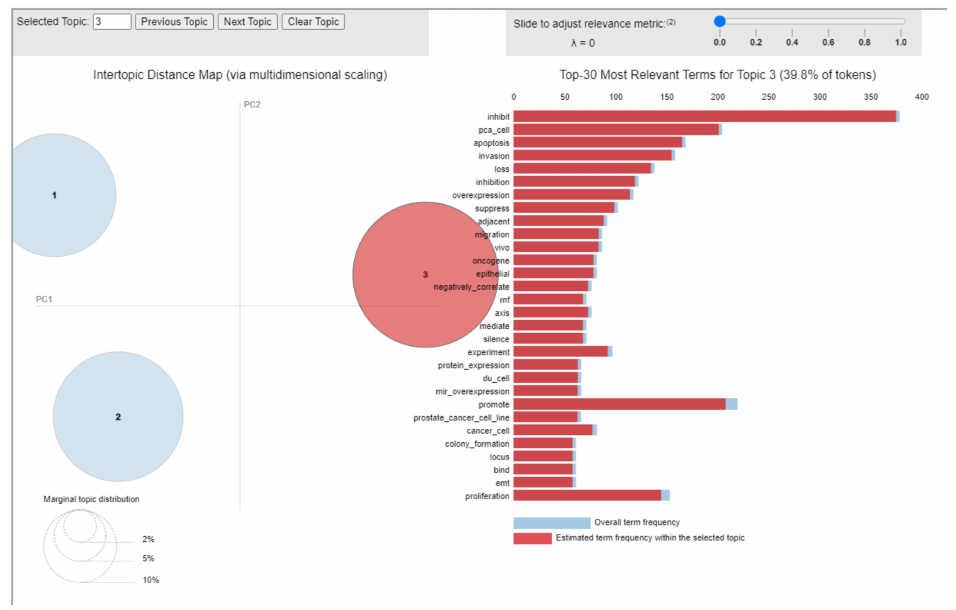
Figure 5. Inter-topic Distance Map related to topic 3. Circle 1 indicates topic 1, circle 2 is topic 2 and circle 3 is topic 3. Table 1. List of the most relevant and representative papers clustered in the topic 3 over